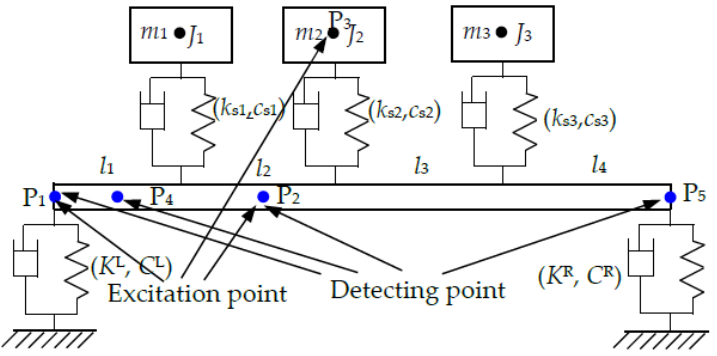
Figure 4. The front view of a thin-walled beam carrying three spring-damper-mass subsystems.